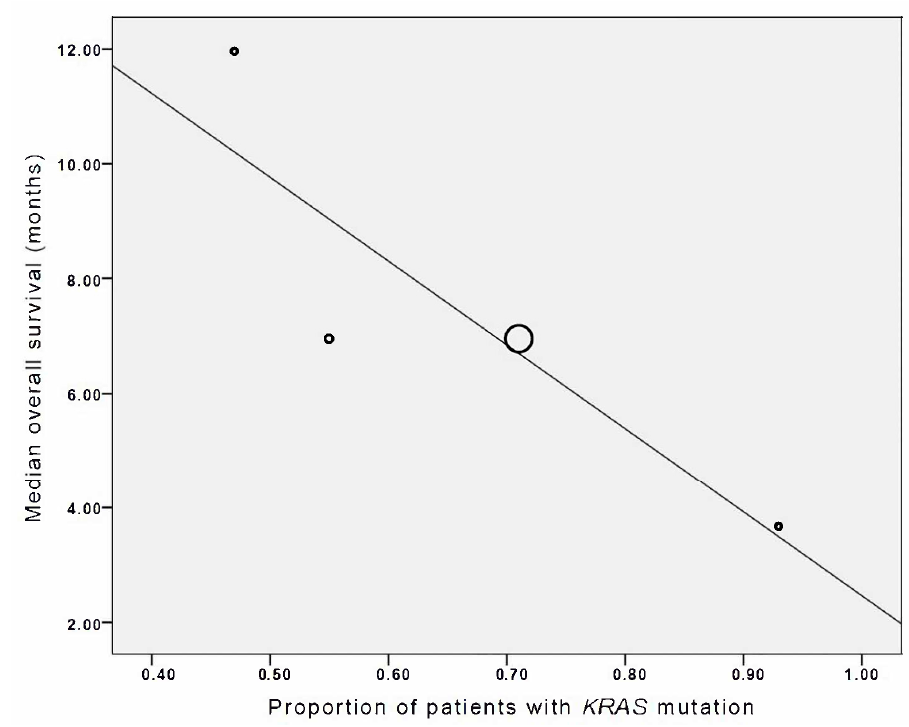
Figure 4. Individual study association of proportion of patients with KRAS mutations and median overall survival (in months). Each study is represented by a circle, and the area of the circle is proportional to the number of patients enrolled in each study. The gradient of the line represents the results of the meta-regression ( R = − 0.88).